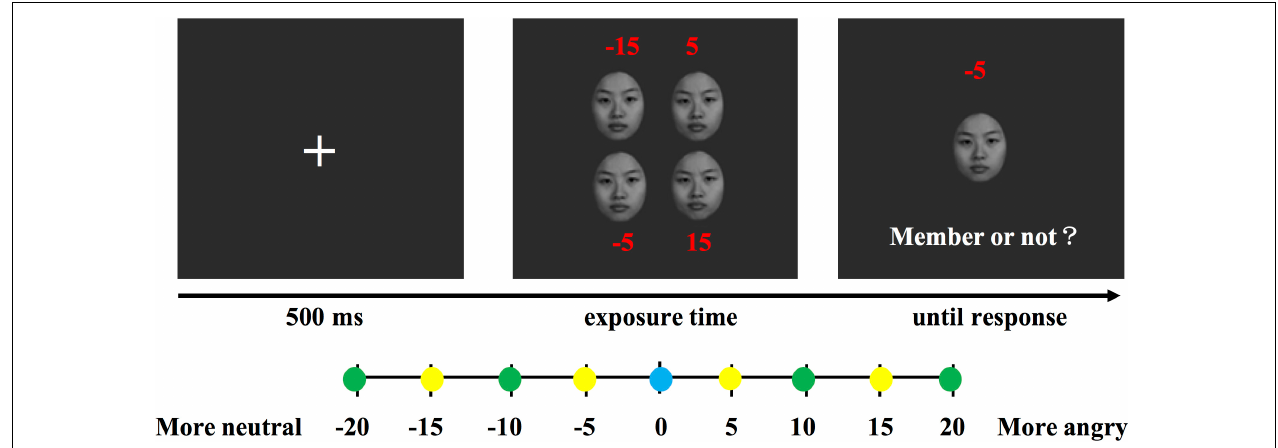
FIGURE 2 | Task design in Experiment 1. The red numbers indicate the emotional intensity of each face compared to the mean face but were invisible in the trials. The test face could be any of the distances indicated by the circles. The yellow circles represent the member test faces of the face set. The green circles represent the neither test faces of the face set. The blue circle represents the mean test face of the face set.